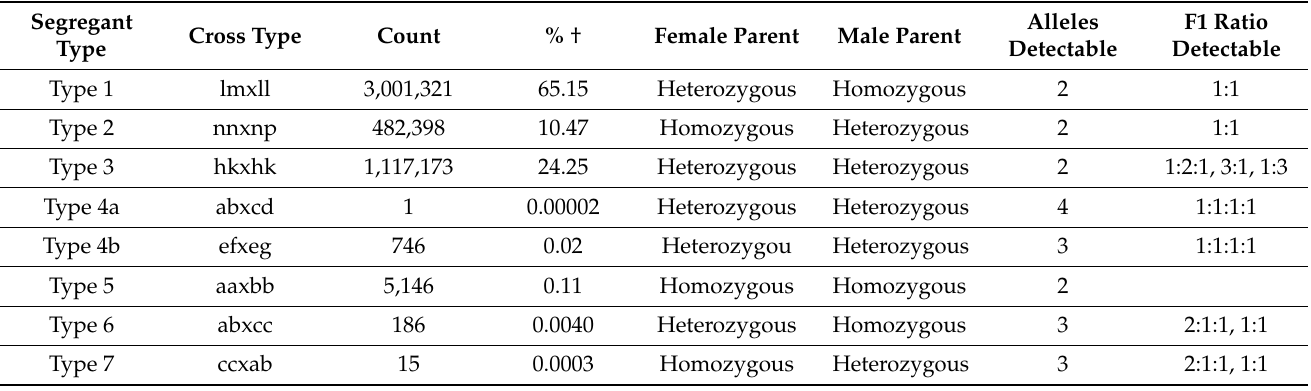
Table 2. Allelic segregation and number of loci in each segregant type among F 1 progeny considered in this study and their genetic